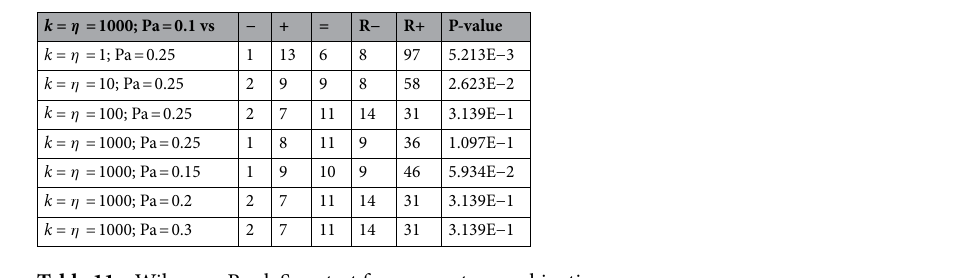
Table 11. Wilcoxon Rank Sum test for parameter combination.